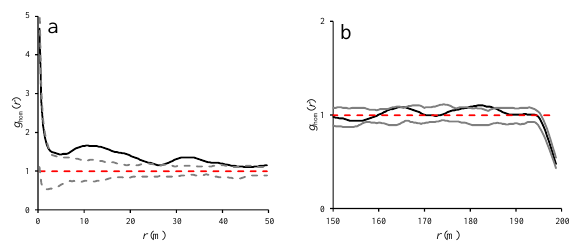
Figure 10. Homogeneous g -function at scales of 0-50 m (a) and 150-200 m (b) for heterogeneous pattern of wild pistachio